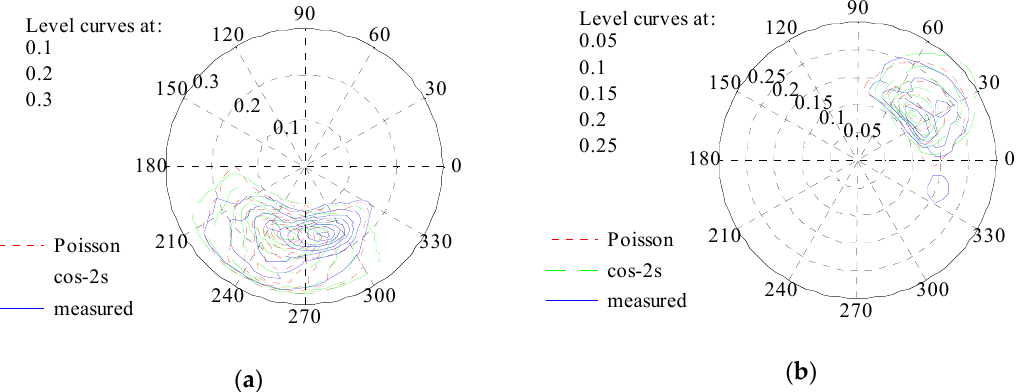
Figure 9. Directional spectra of measured data from radar and theoretical calculations for ( a ) H s = 1.0583 m and ( b ) H s = 0.6069 m.